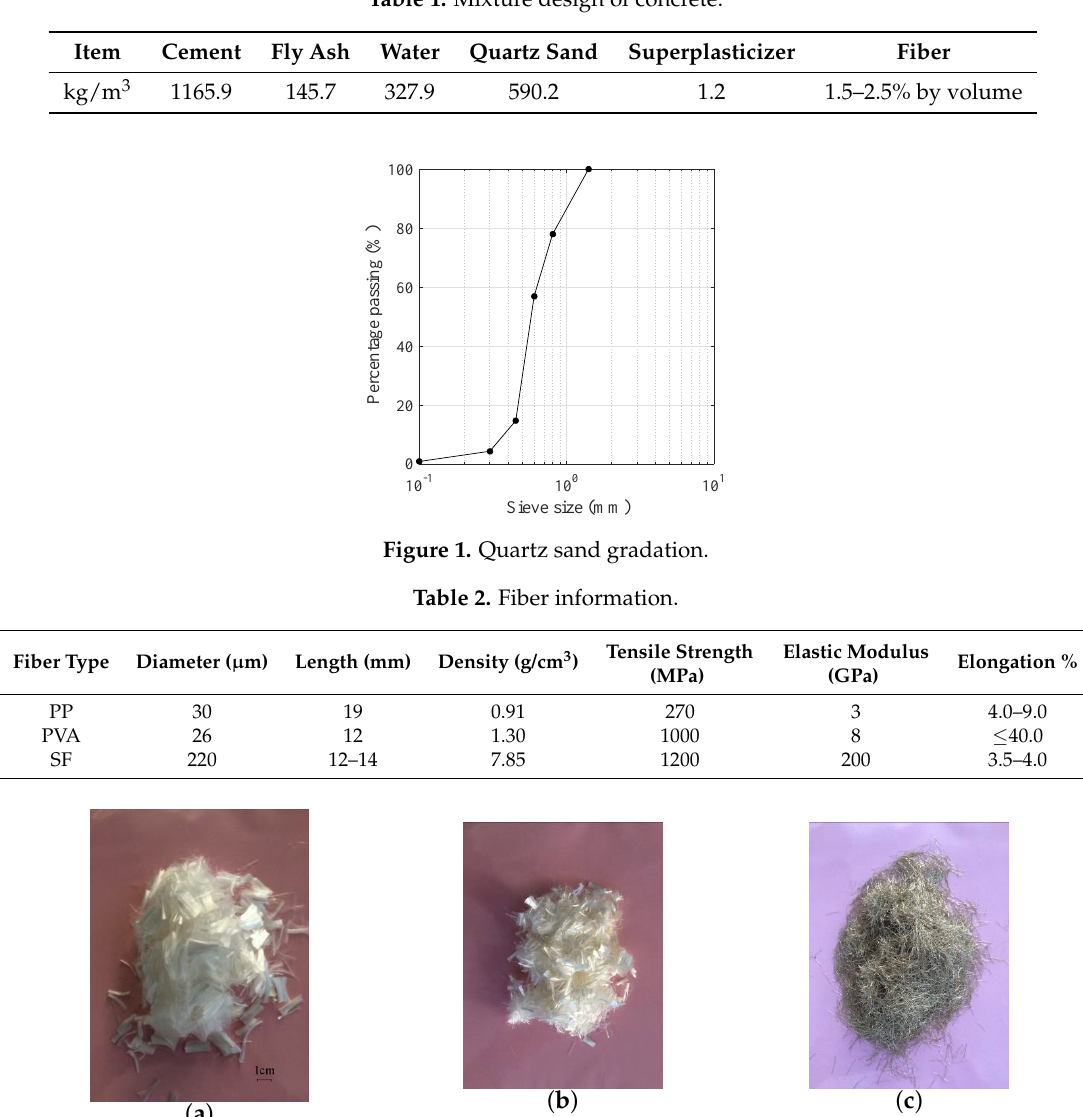
Table 1. Mixture design of concrete.